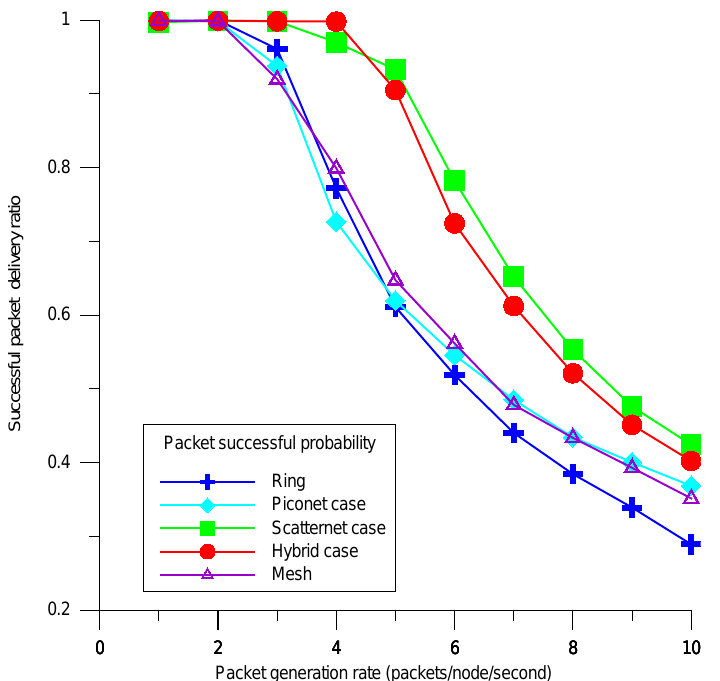
Figure 9. The packet successful probability (PSP) performance of the Reconfigurable Mesh-Ring (RMR) algorithm.